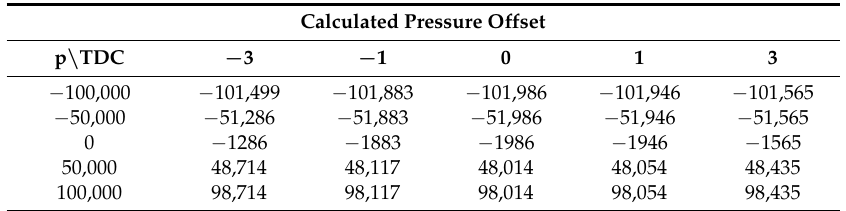
Table 7. Calculated pressure and TDC offsets and their absolute errors for the PSA engine and operating point 2000 1/min and 100 Nm using the on-line